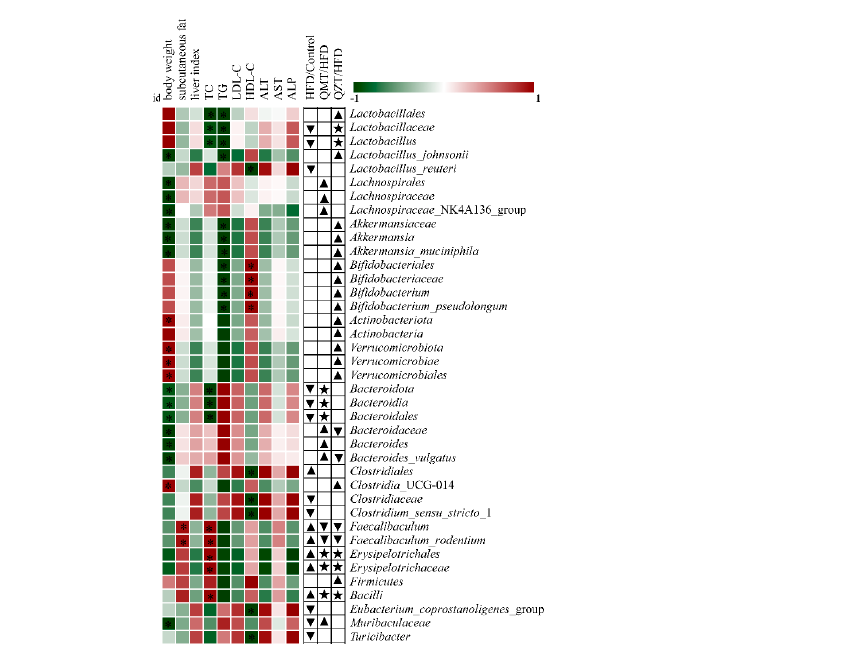
Figure 5. Heatmap of Spearman’s correlation between the most differentially abundant taxa (altered by HFD, QMTe, and QZTe intervention) and obesity-related phenotypes in mice. ▲ , significantly more abundant; ▼ , significantly less abundant; ★ the microbiota altered significantly by HFD feeding was restored to normal by QMTe/QZTe treatment. 3.5. Gut Microbiota Differentially Mediated by QMTe and QZTe Alleviated HFD-Induced Obe- sity and Associated Metabolic Disorders Spearman’s correlation analysis was carried out to reveal the gut microbiota contrib- uting to the inhibitory effects of QMTe and QZTe on HFD-induced obesity. The heatmap (Figure 5) displayed the association between the most differentially abundant taxa (al- tered by HFD, QMTe, and QZTe intervention, shown in Figure 4) and obesity-related phe- notypes, including body weight, subcutaneous fat, liver index, TC, TG, LDL-C, HDL-C, ALT, AST, and ALP. It was revealed that the Lactobacillales , Lactobacillaceae , and Lactobacil- lus were negatively correlated with TC and TG, and Lactobacillus _ johnsonii was negatively related to body weight and TG. In supporting this observation, Wang et al. [35] reported that the relative abundance of Lactobacillales was highly negatively linked with TC and LDL-C in HFD-fed mice. Yang et al. [36] also found that Lactobacillus could enhance the activity of bile brine hydrolysis enzymes and the content of unbound bile acids, and thus, increase the fecal lipid excretion and reduce lipid accumulation. The enrichment of Lacto- bacillales and Lactobacillus _ johnsonii , and the restoration of Lactobacillaceae and Lactobacillus by QZTe treatment, may contribute to reducing body weight and improving lipid levels in HFD-fed mice. It was also observed that Lachnospirales , Lachnospiraceae , and Lachnospi- raceae _NK4A136_group were negatively related to body weight. This result is consistent with previous studies in which Lachnospiraceae was butyric acid-producing bacteria and the administration of Lachnospiraceae attenuated obesity, inflammation, and dysbiosis